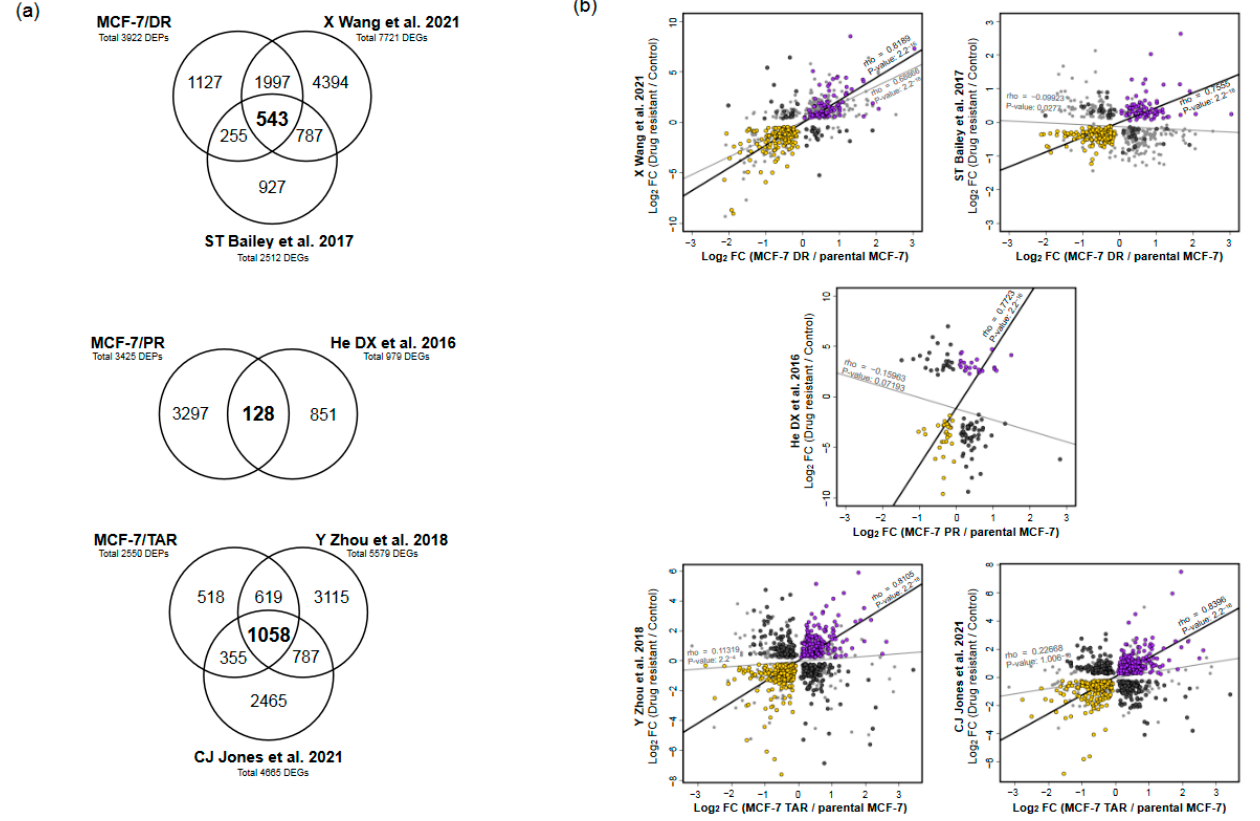
Figure 3. Integrative analysis of proteome and transcriptome of drug-resistant cells. ( a ) Venn diagram of significantly differentially expressed genes between proteome and each publicly available transcriptome. ( b ) Scatter plots of gene-expression correlation between proteome and transcriptome data from each study. Genes for mRNA and protein with increasing concordance were indicated with purple, while genes with decreasing concordance were marked with yellow. Genes that showed discordant changes between proteome and all transcriptome profiles were indicated as dark grey.